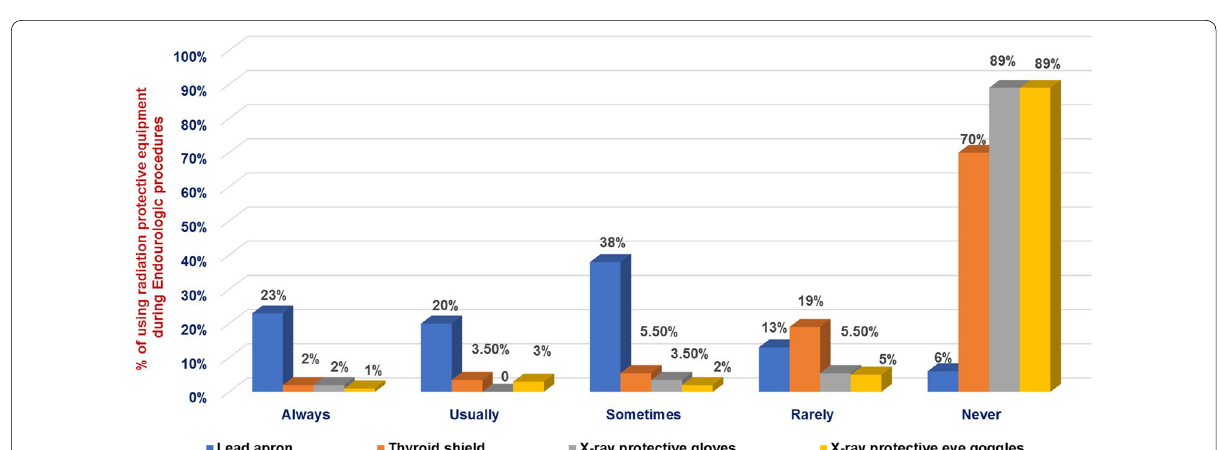
Fig. 1 Percentage of all participants who use radiation protective equipment in terms of lead aprons, thyroid shield, X‑ray protective gloves and X‑ray protective eye goggles during Endourologic